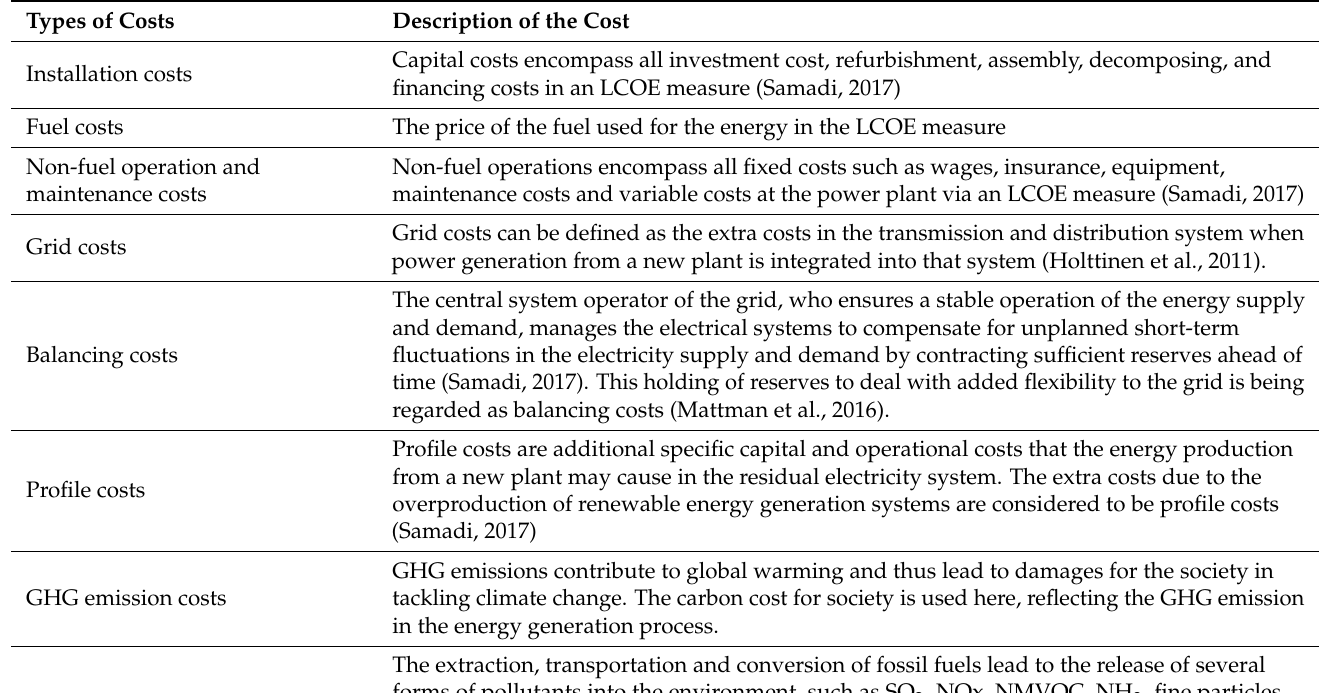
Table A1. Description of the true costs in the cost price of energy